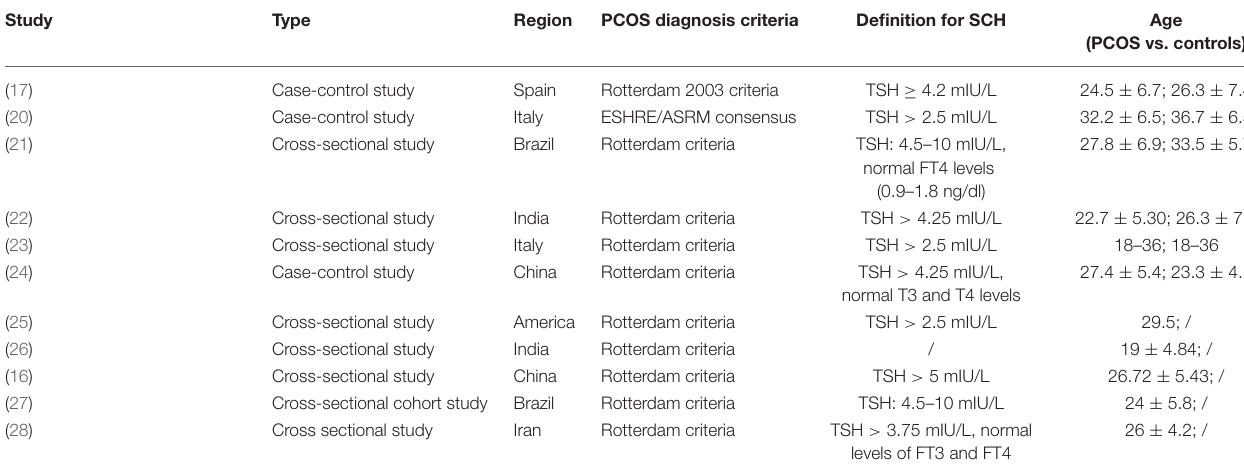
TABLE 1 | General characteristics of studies included in the systematic